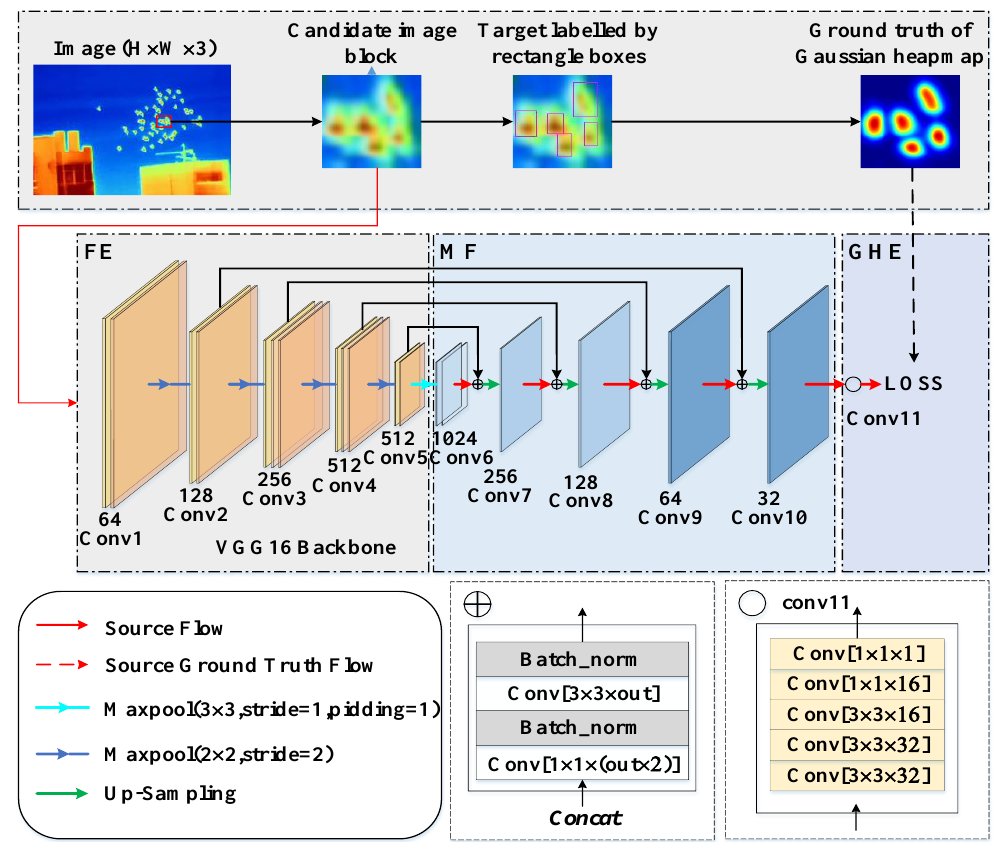
Figure 4. The structure diagram of the GHPNet.